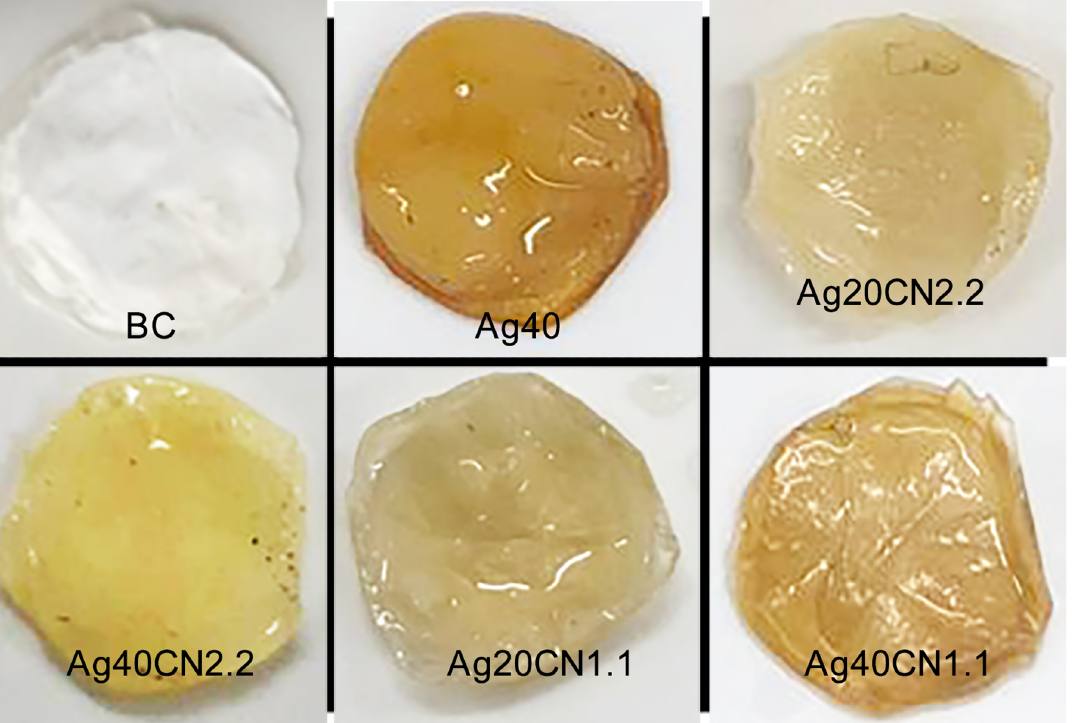
Figure 3. Photographs of the pure BC and the functionalized membranes with Ce(NO3)3 and